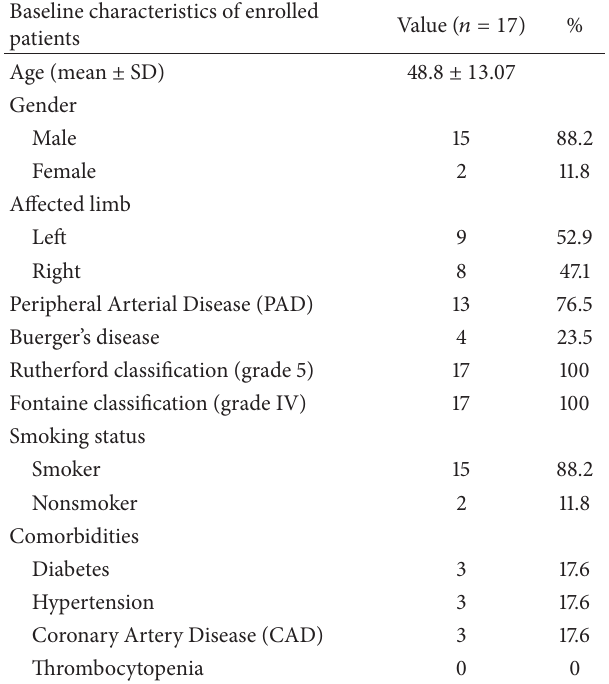
Table 1: Clinical characteristics of the patients enrolled in the study at baseline.